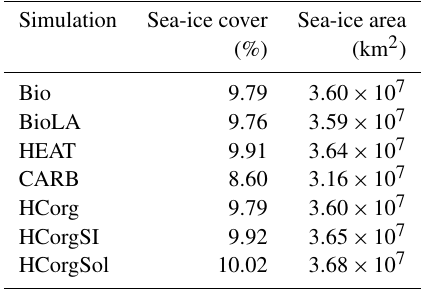
Table F1. Global sea-ice cover (%) and global sea-ice area (km 2 ) for the different